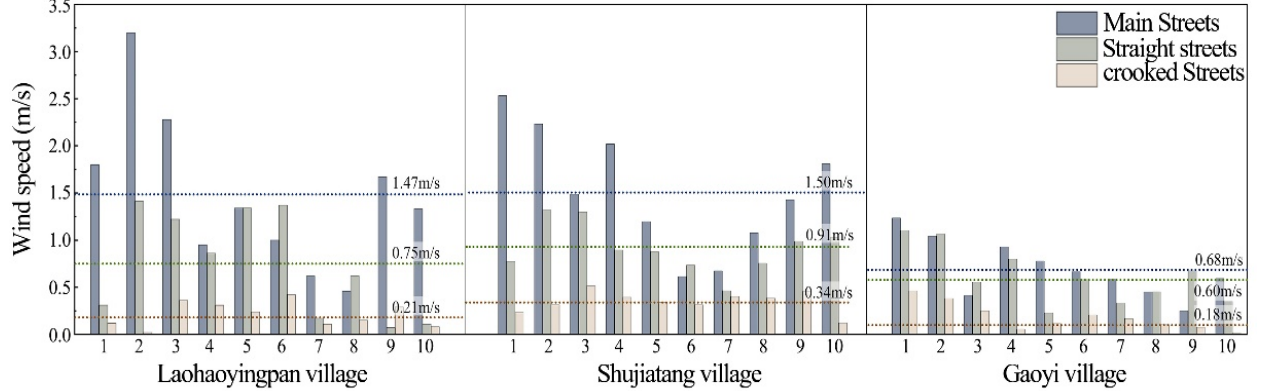
Figure 15. Windspeed monitoring results for different forms of streets and alleys in different ancient villages.